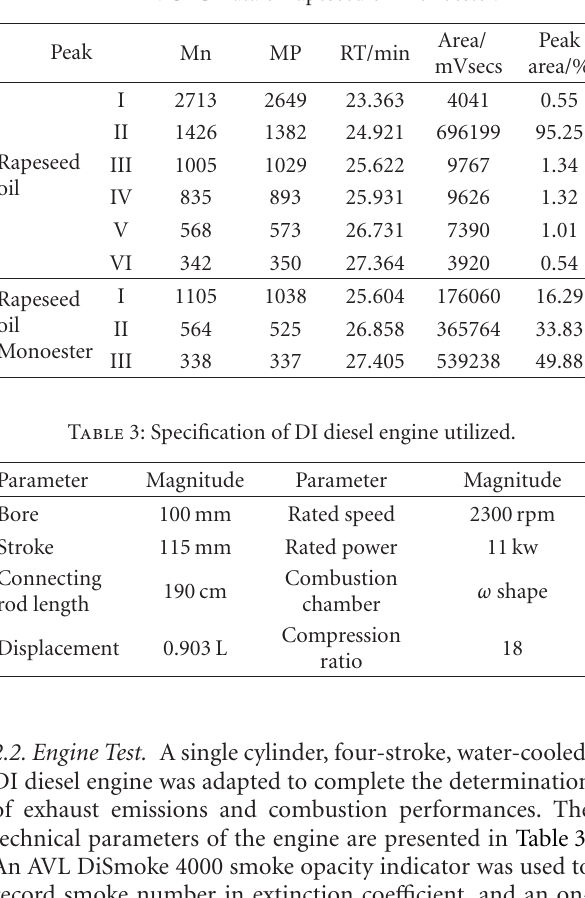
Table 2: GPC Data of rapeseed oil monoester.